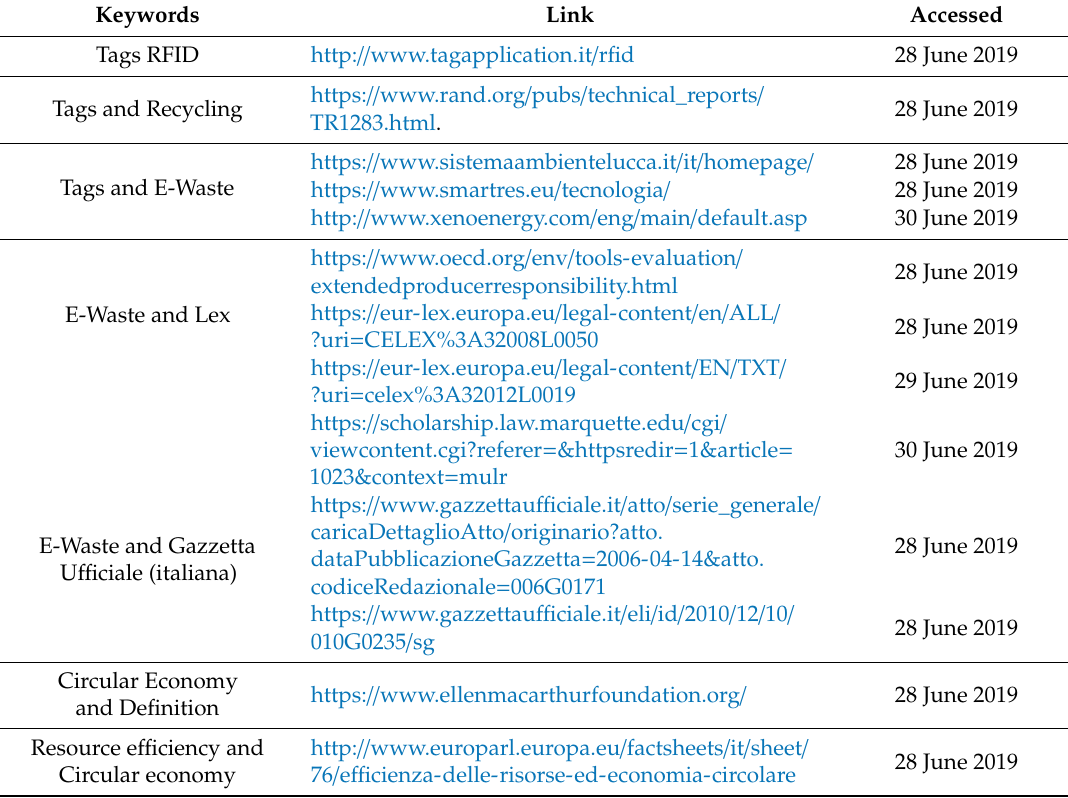
Table 2. List of companies that use RFID tags: keywords of research, websites, and date of